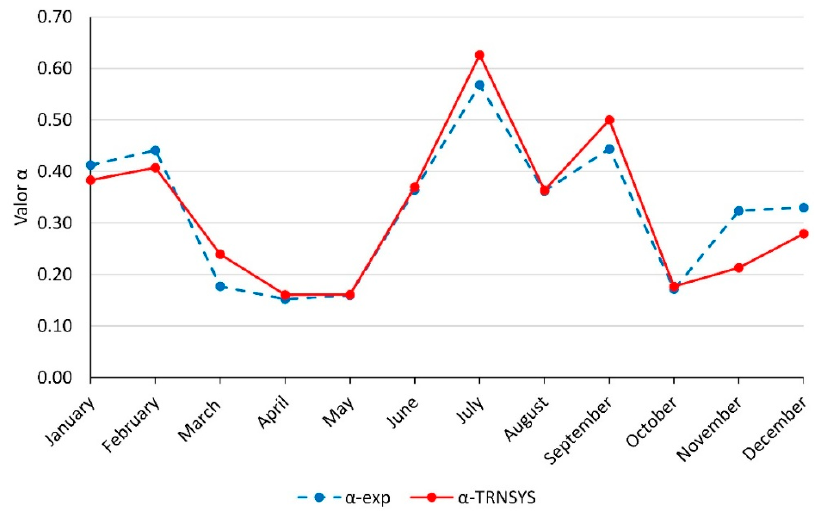
Figure 11. Partial load ratio simulation results.